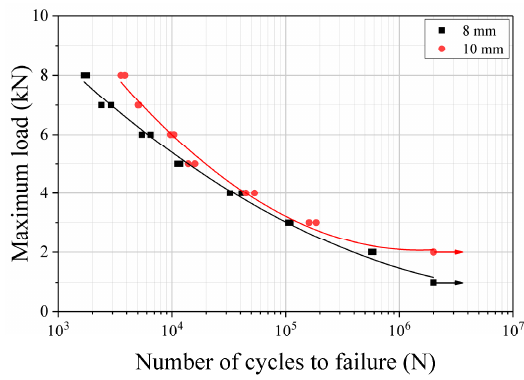
Figure 6. Load-Number of cycles to failure curves of 980 MPa steel spot welded specimens.